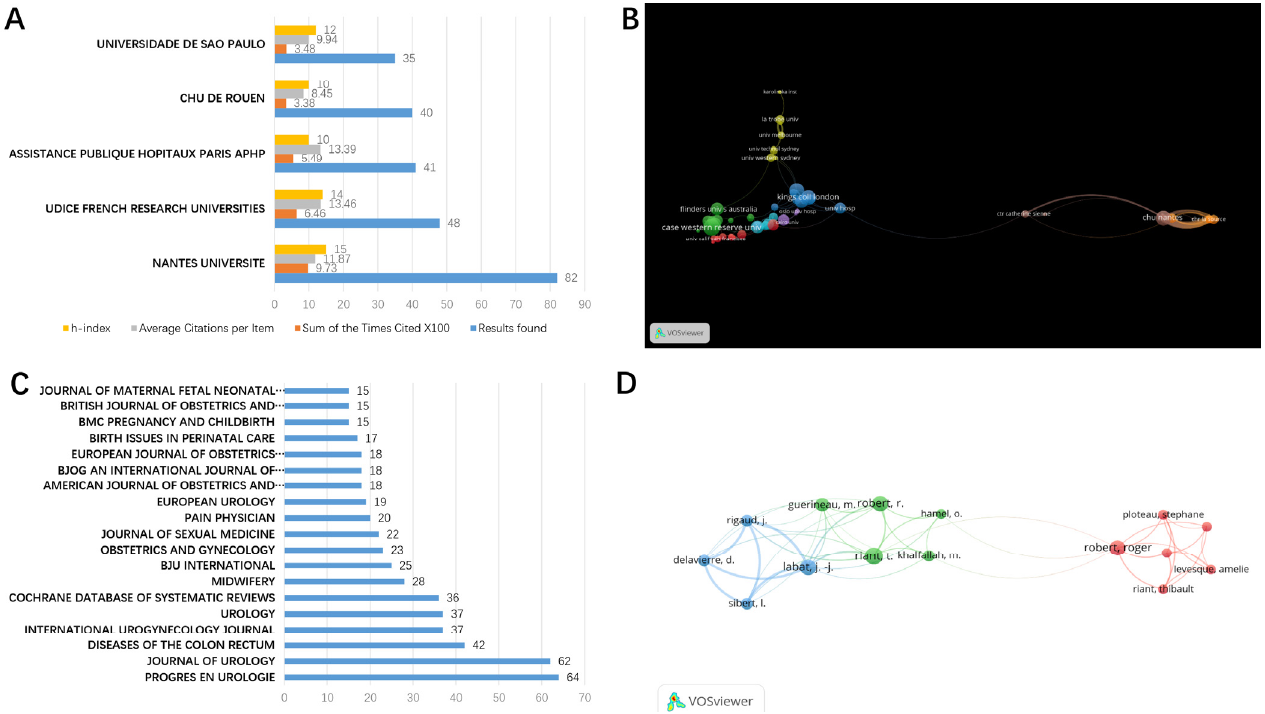
Figure 2. Institutions and author collaborations. ( A ) The total citations, average citations per paper, and H-indexes for perineal pain articles from institutions across the world. ( B ) The collaboration network of institutes with a notable interest in perineal pain research. ( C ) The number of articles from each journal. ( D ) The collaboration network of authors publishing research on perineal pain.